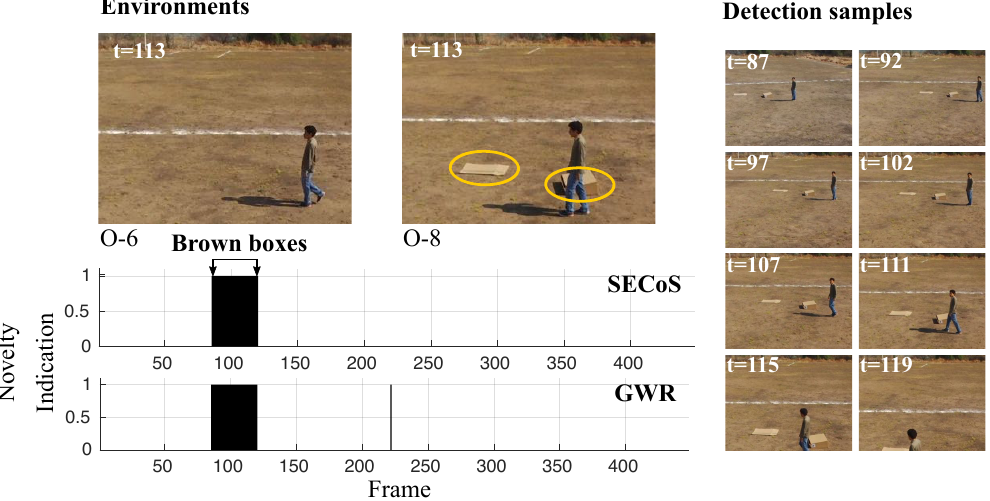
Figure 20. Visual results in novelty detection on dataset D-7 (the brown boxes as the novel